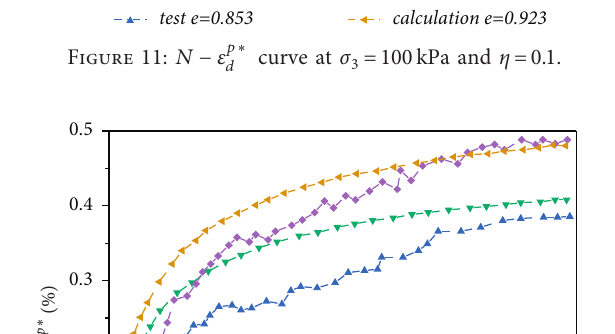
Figure 11: N − ε p ∗